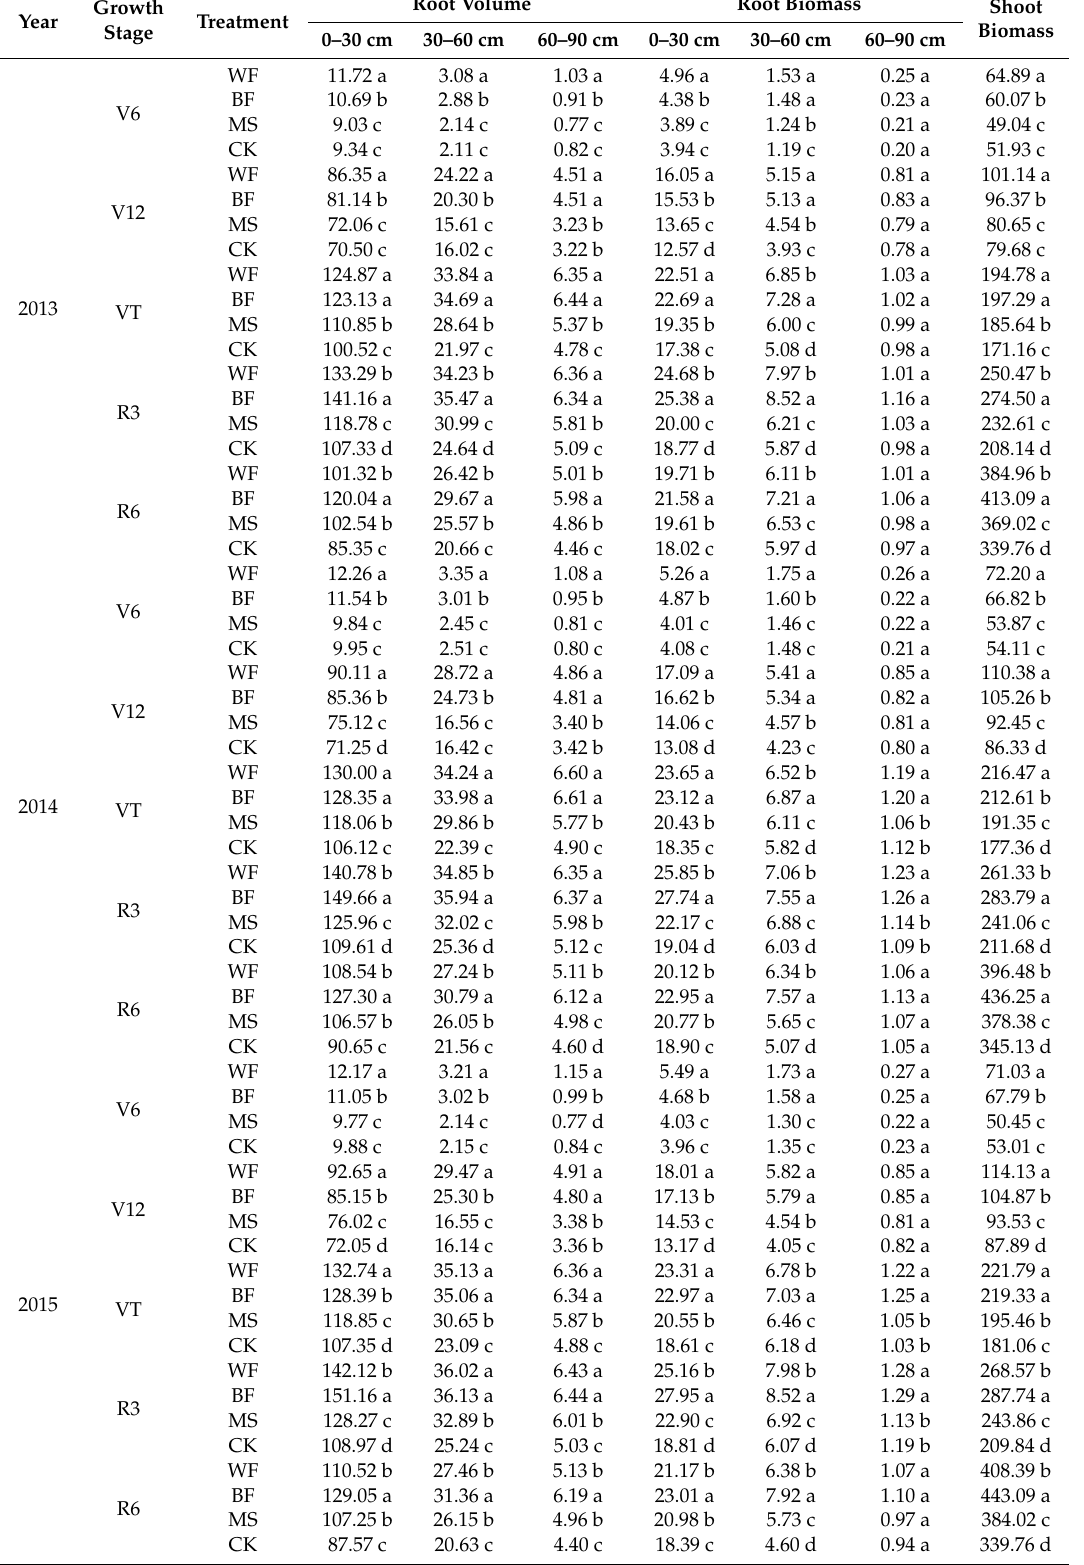
Table 6. Root volume (cm 3 plant -1 ) and root biomass (g plant -1 ) in the 0–90 cm soil profile, and shoot biomass (g plant -1 ) for the di ff erent growth stages under di ff erent